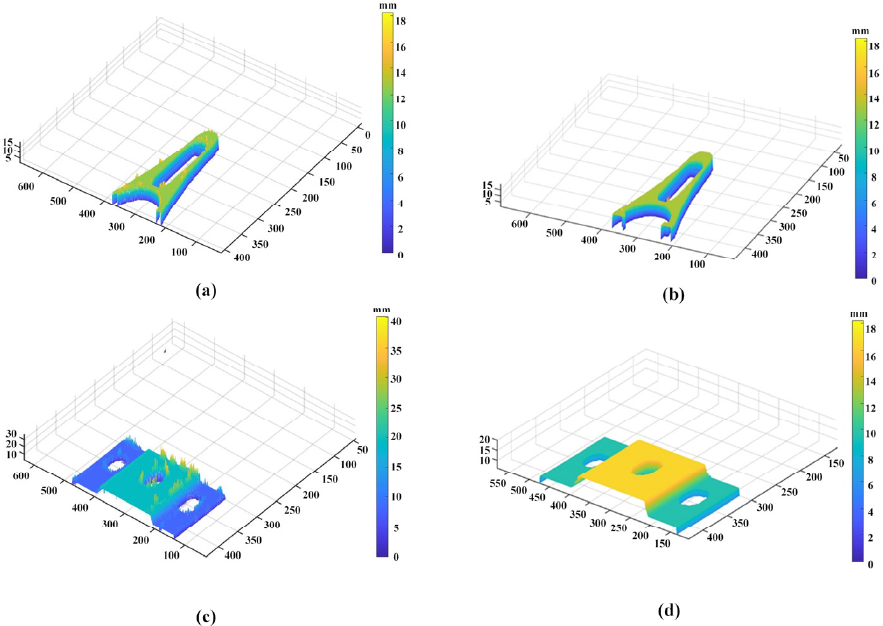
Figure 10. 3D reconstruction results of different methods. ( a ) traditional EPI for object 1; ( b ) our approach for object 1; ( c ) traditional EPI for object 2; ( d ) our approach for object 2. Table 1. Comparative analysis of